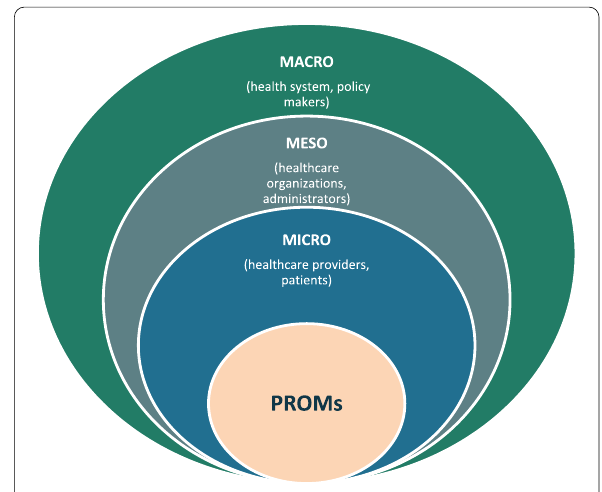
Fig. 1 A multi‑level approach for the use of PROMs data